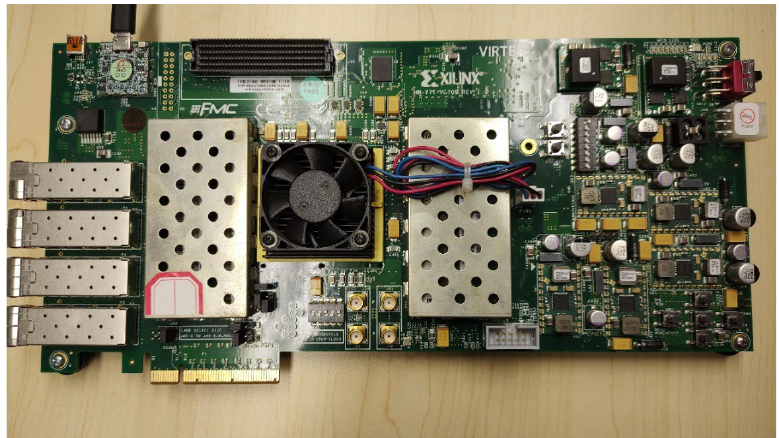
Figure 10. Xilinx VC709.